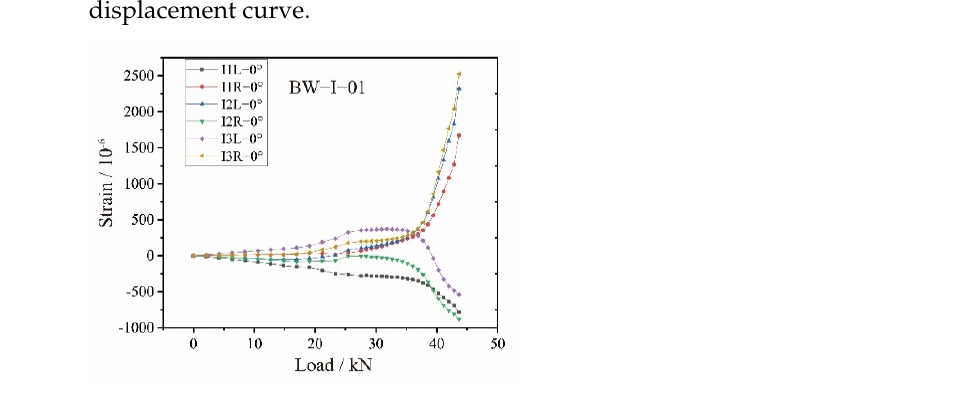
Figure 5. The strain-load curves of different measurement points in the web region of the BW-I-01 specimen.